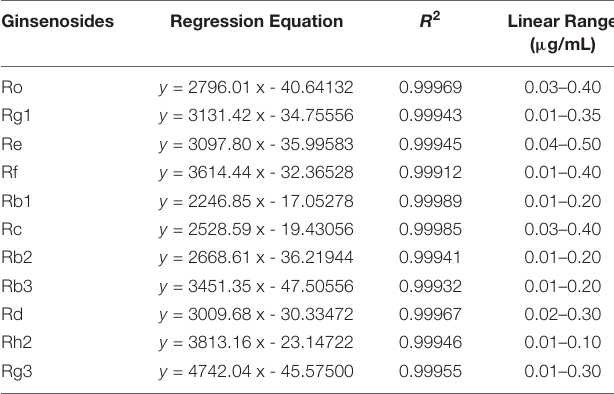
TABLE 2 | Linear regression equations, correlation coefficients, and linearity ranges of 11 ginsenosides. Ginsenosides Regression Equation R 2